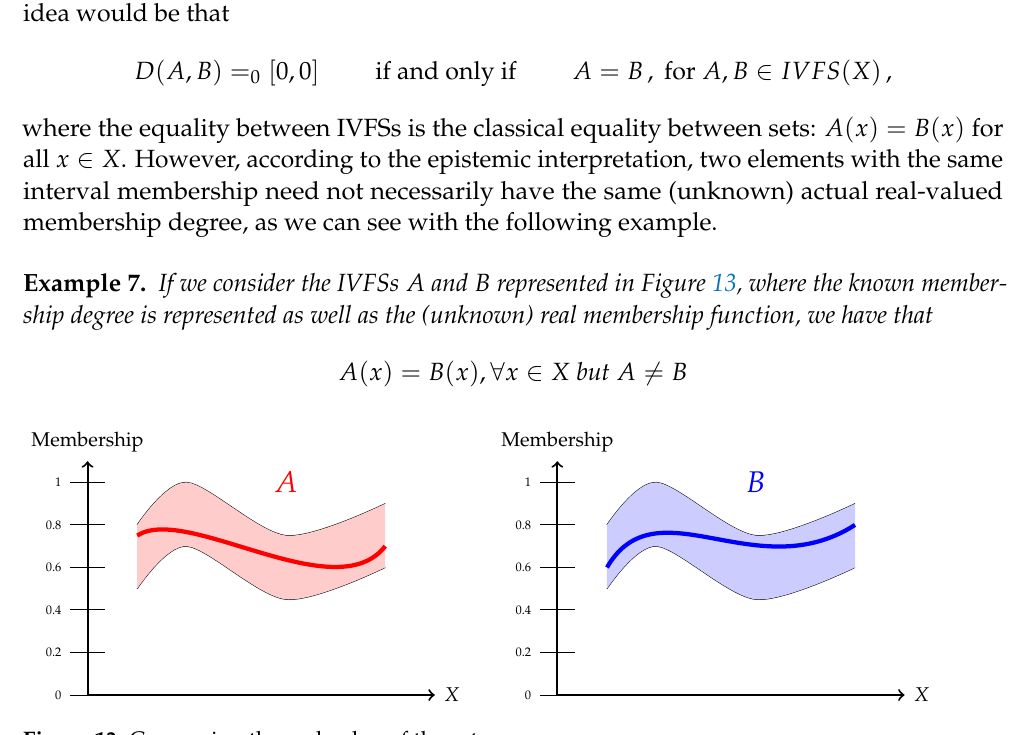
Figure 13. Comparing the real value of the